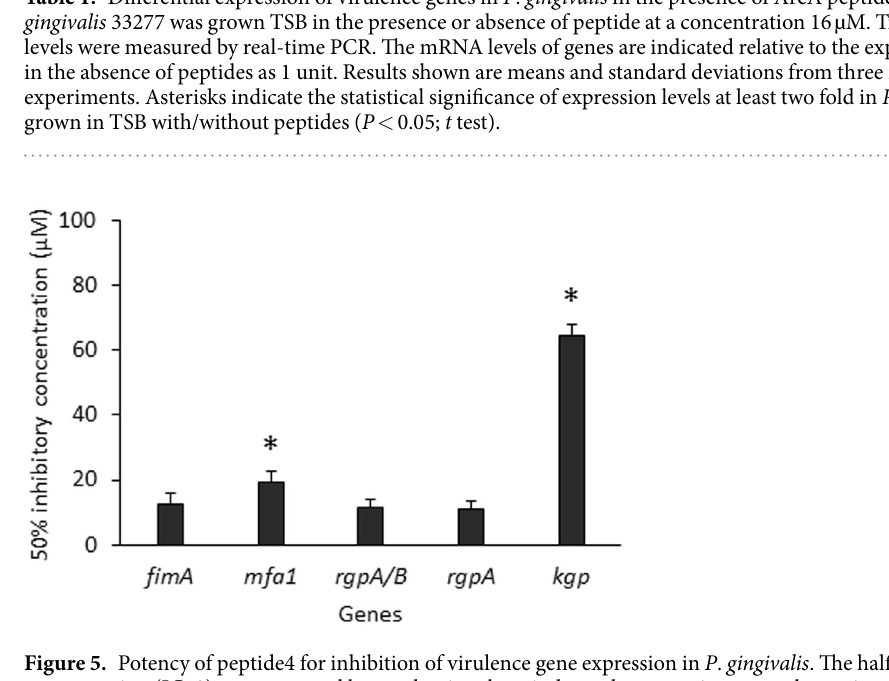
5 Scientific RepoRts | 7: 1413 | DOI:10.1038/s41598-017-01551-4